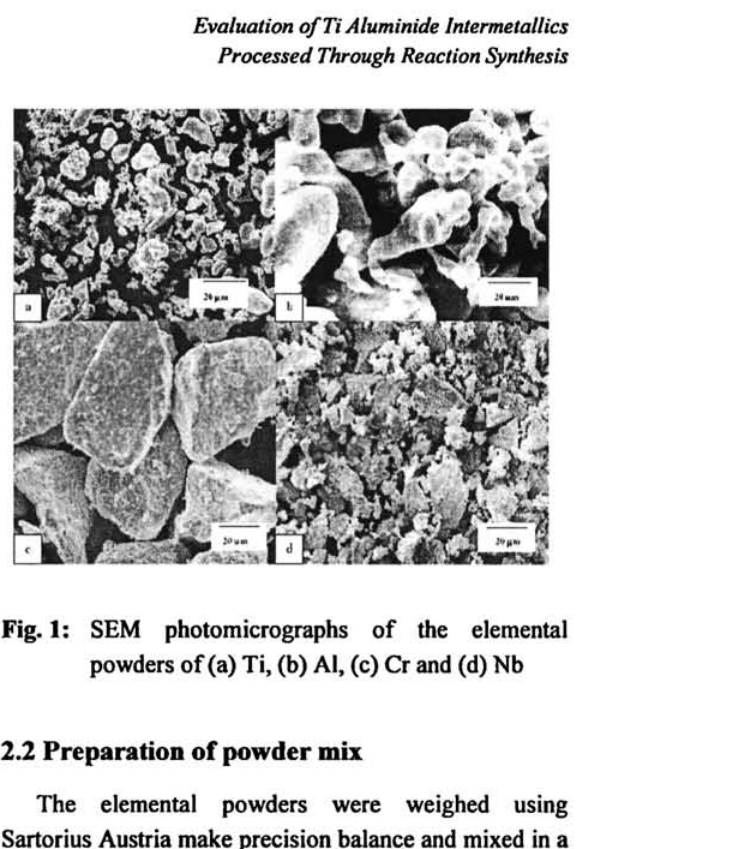
Fig. 1: SEM photomicrographs of the elemental powders of (a) Ti, (b) AI, (c) Cr and (d)